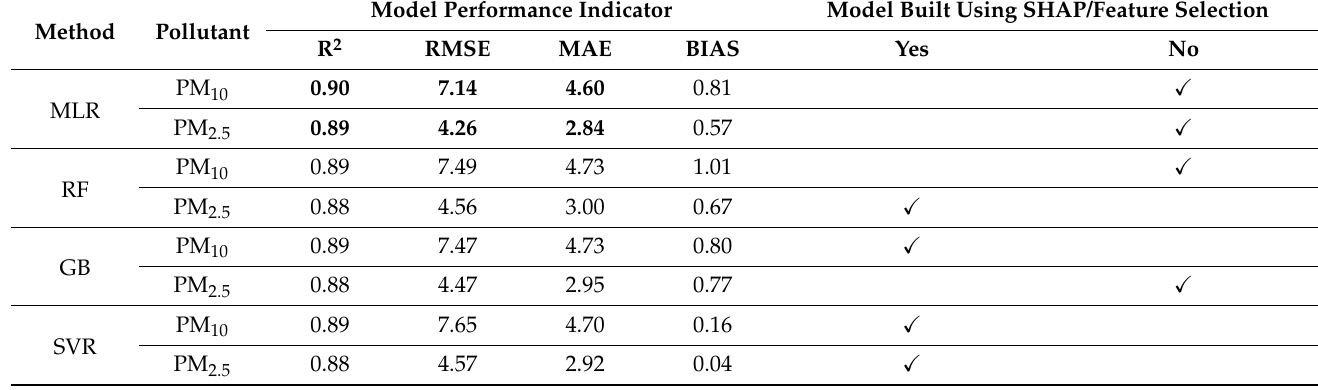
Table 2. Comparison of the MLR, RF, GB, and SVR models trained using 2013–2018 data and tested on 2019 data.